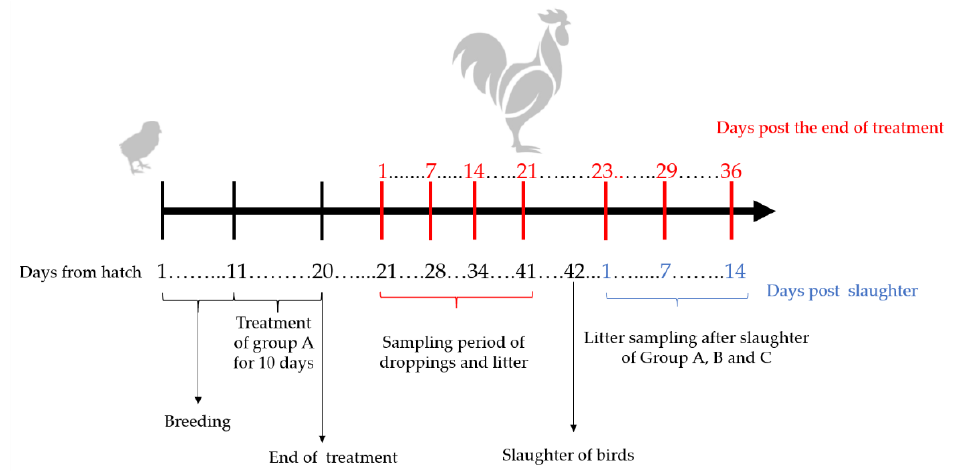
Figure 2. Schematic diagram of treatment and sampling period.